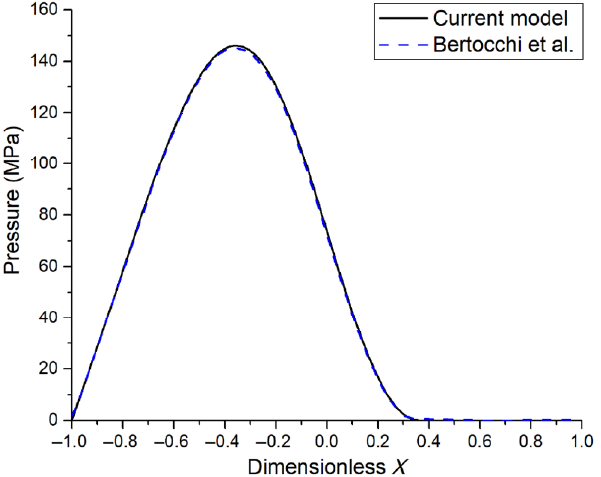
Fig. 4 The comparison results involving the hydrodynamic pressure